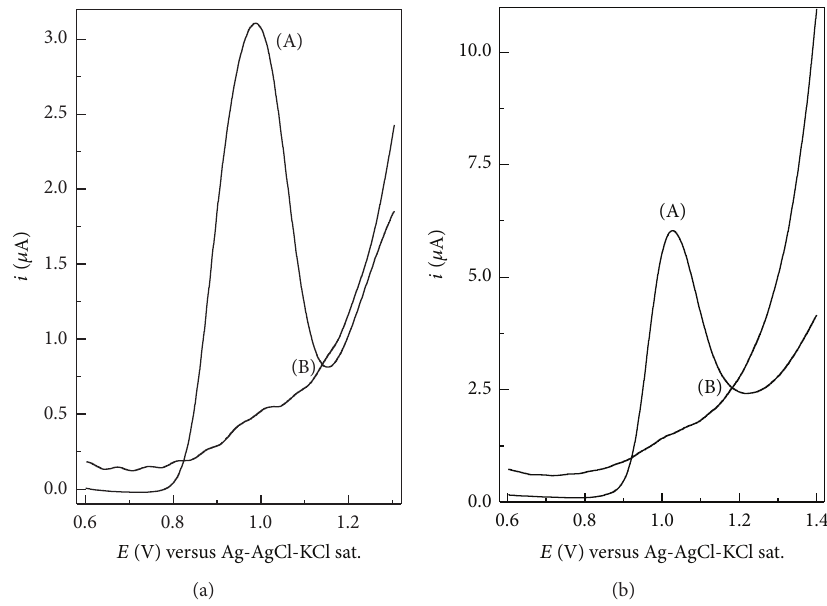
Figure 4: (a) Differential pulse and (b) square wave voltammograms of 5.0 × 10 −5 M FXN in phosphate buffer solution (0.2 M, pH 4.7) at (A) MIPpy and (B) MIPpy/GCE. Other conditions are shown in Figure